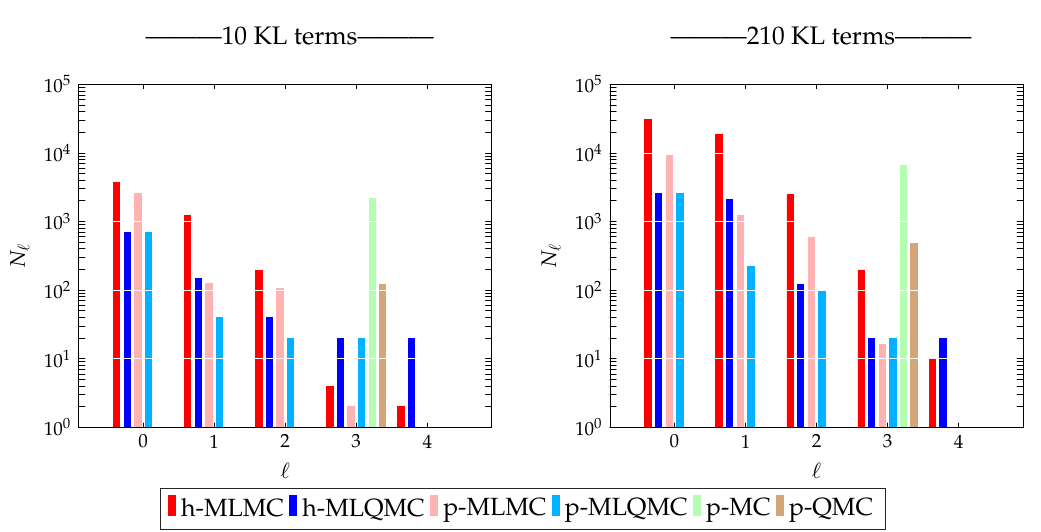
Figure 26. Number of samples for the different methods for model problem